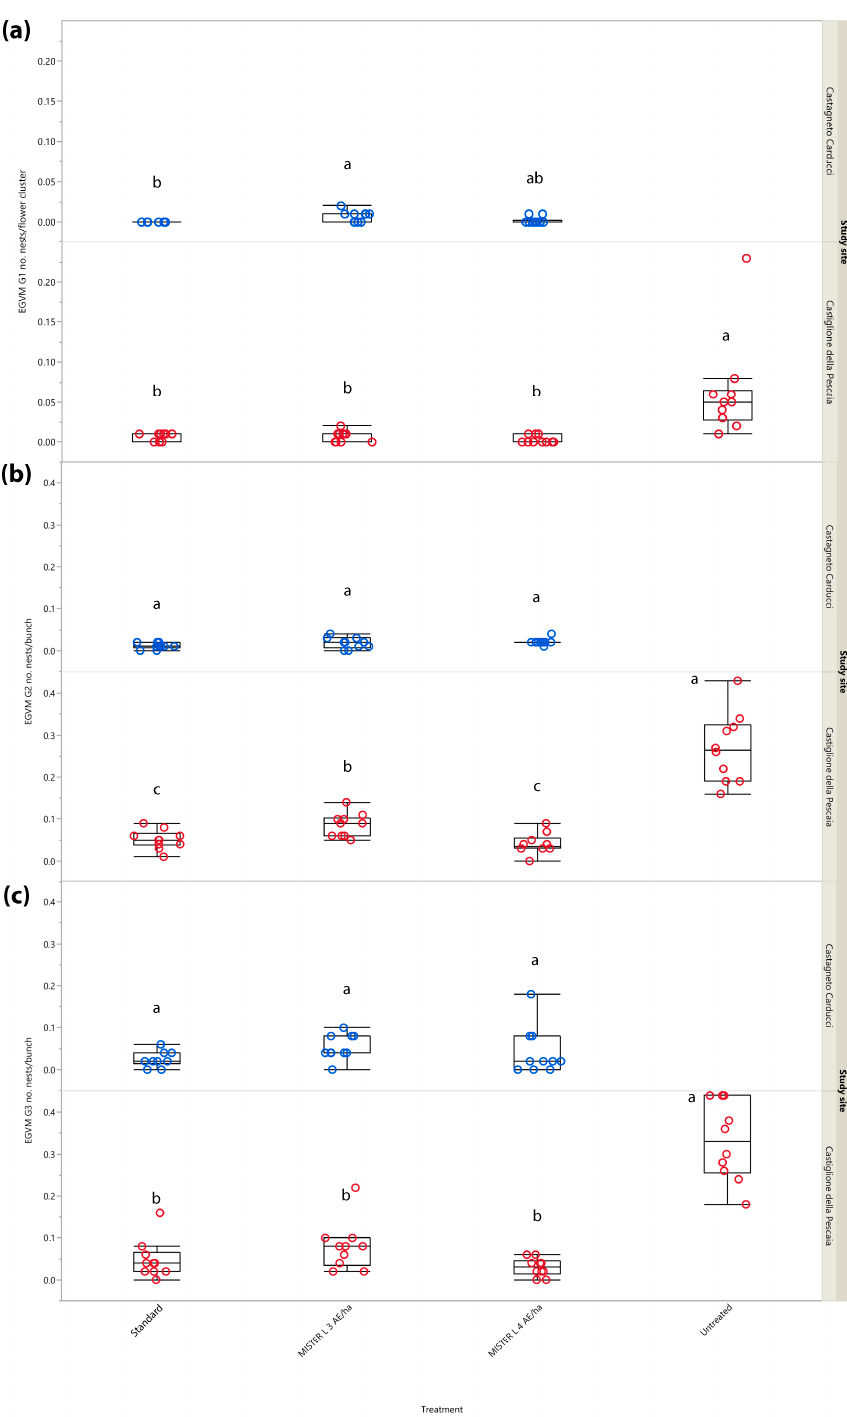
Figure 5. Impact of mating disruption using Isonet ® L MISTERX843 on the number of Lobesia botrana (EGVM) nests per flower cluster (G1) or bunch (G2 and G3) in Tuscany during 2018. Box plots indicate the median (solid line) within each box and the range of dispersion (lower and upper quartiles and outliers) of the infestation parameter. ( a ) G1: first generation; ( b ) G2: second generation; ( c ) G3: third generation (harvest). Within each generation and study site, different letters above box plots indicate significant differences between treatments (Kruskal–Wallis test followed by Steel–Dwass test, p < 0.05).